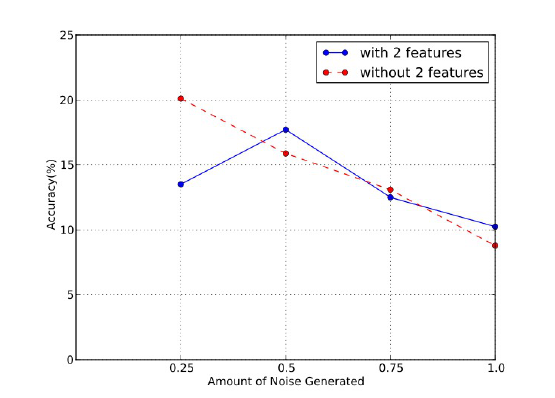
Figure 8. The accuracy using the Random Forest algorithm when considering the incoming packet features or not.